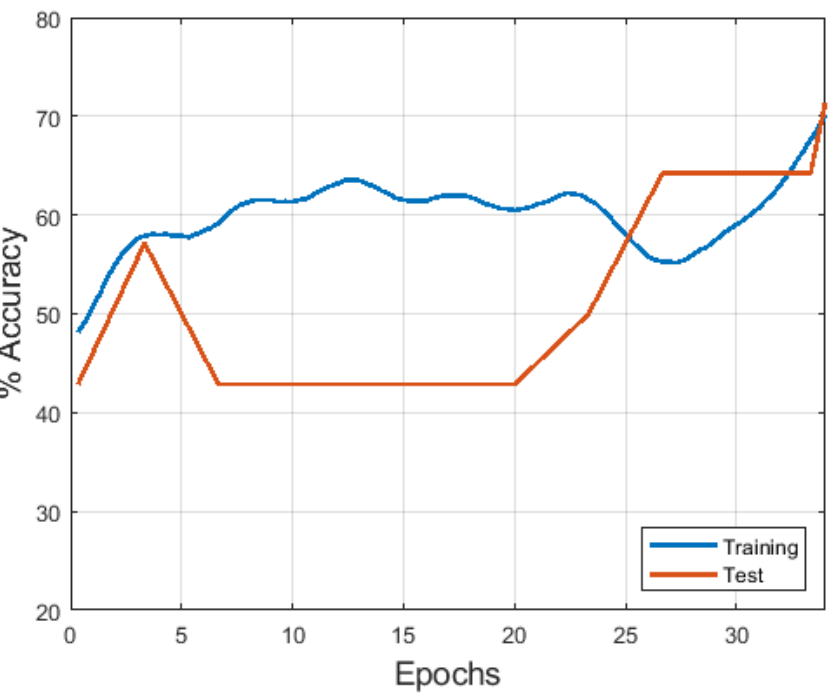
Figure 5. Graph showing the accuracy of the BLSTM neural network during the 250 epochs of training, both in the training (blue), and test sets (red).